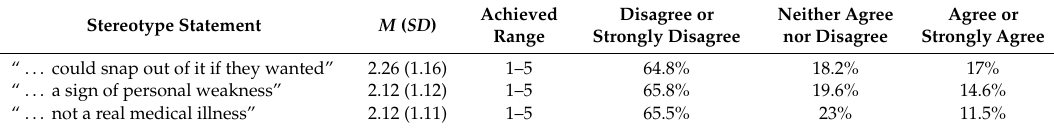
Table 1. Adolescents’ endorsement of items comprising the ‘weak-not-sick’